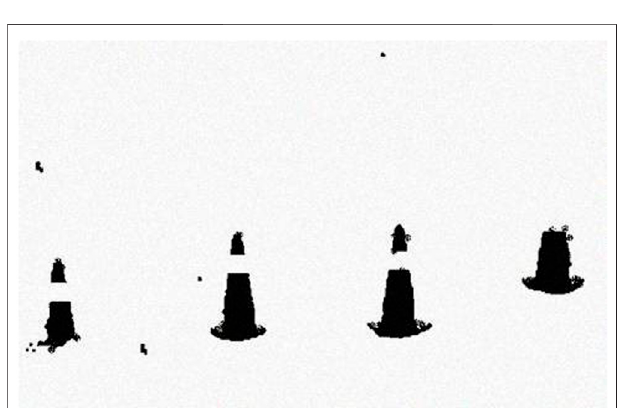
FIGURE 8 | Pre-processed images.